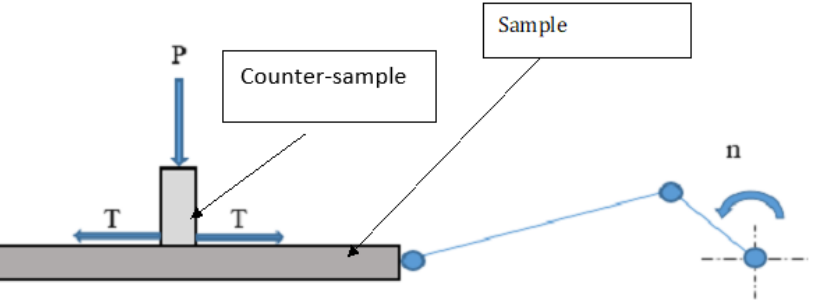
Figure 2. Schematic representation of the tribological tester, P—load, T—friction force, n—rotational speed converted to reciprocating motion.